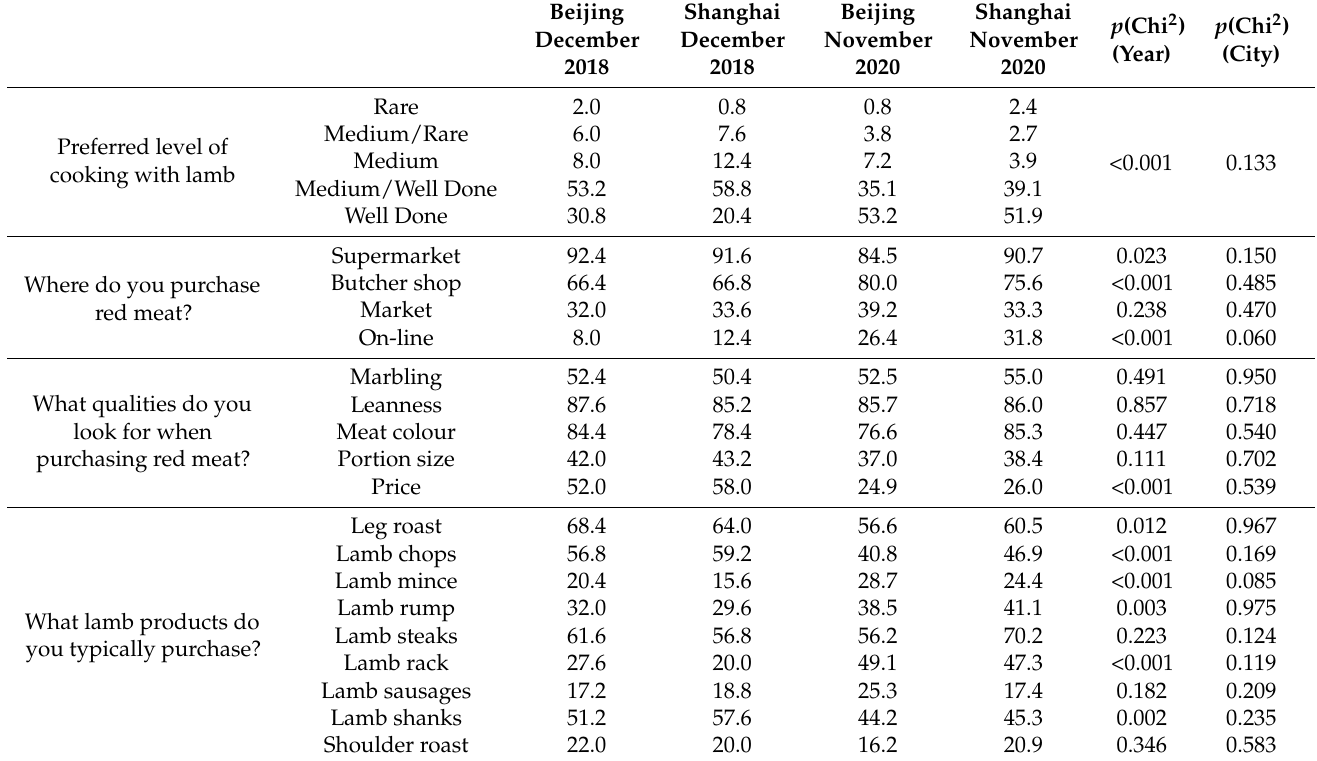
Table 3. Preferred level of cooking, meat qualities of interest to consumers at the point of purchase and purchase and purchase frequency of different lamb products (%) ( p value determined using a Fishers exact test (Chi-squared) for both year and